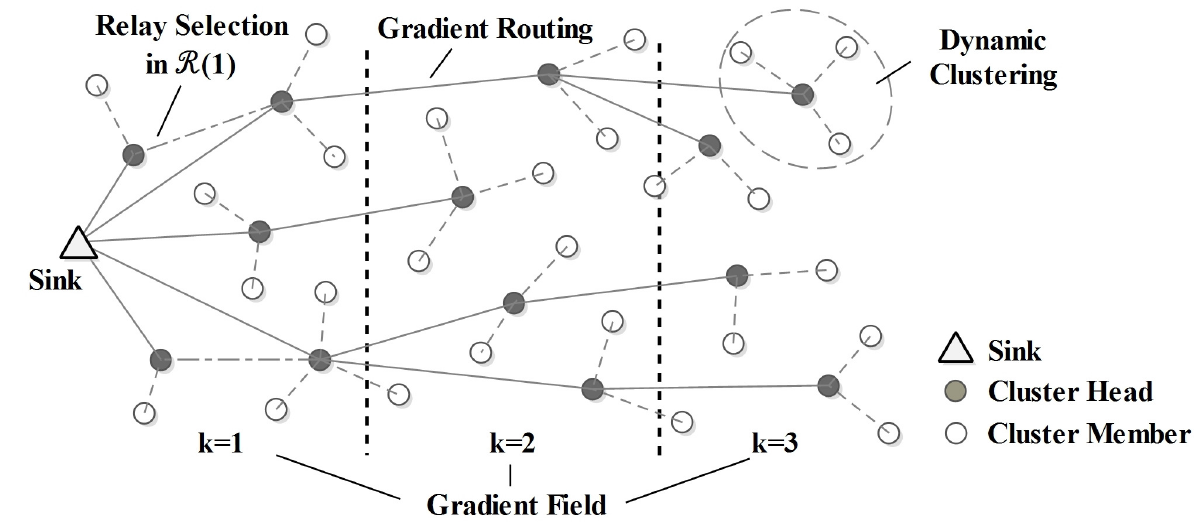
Figure 3. The network topology of